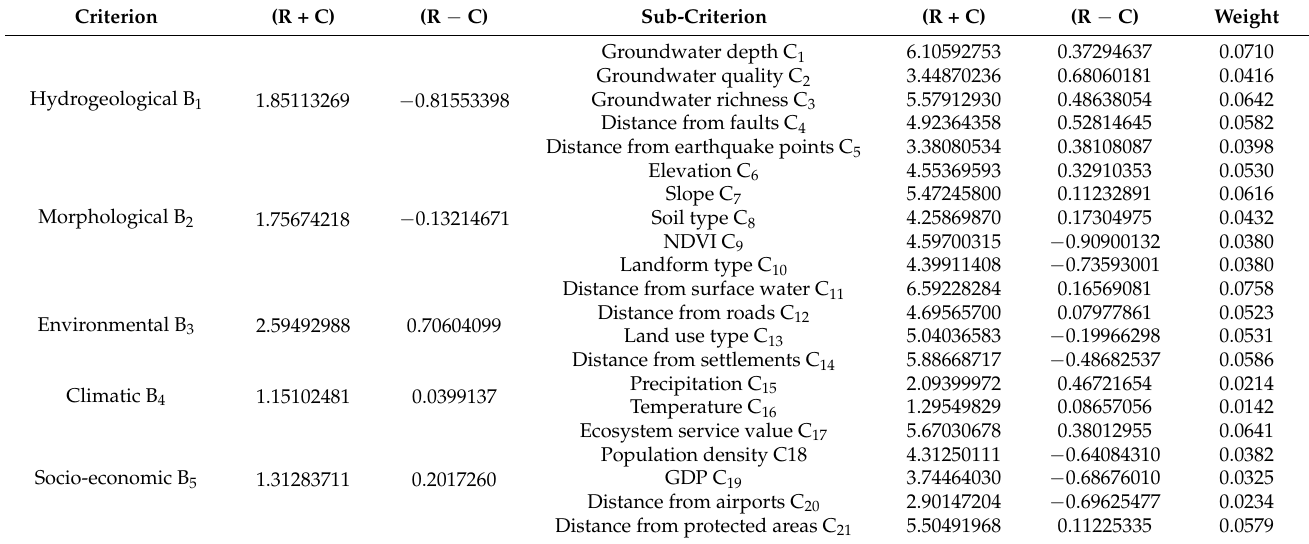
Table 1. M(R + C), N(R − C) and weights for criterion and